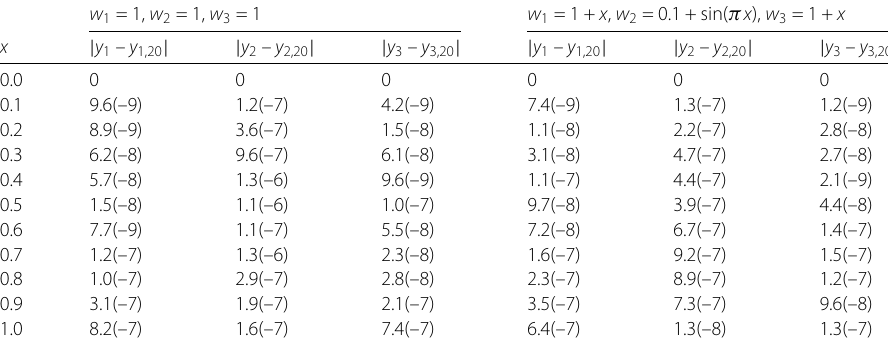
Table 6 Absolute errors of the presented method with n = 20 for Example 2